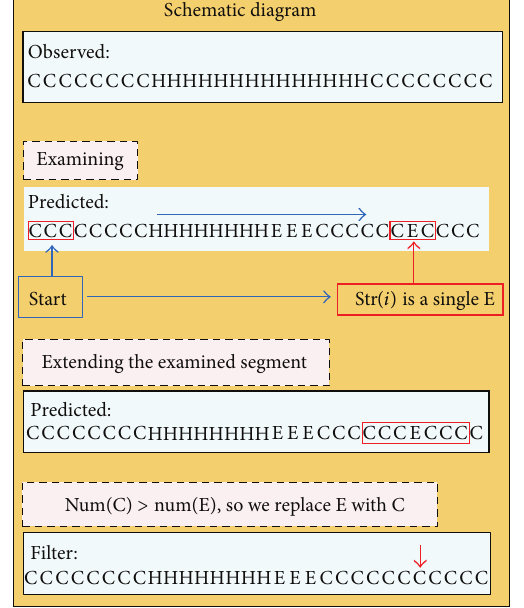
Table 4: Side chain mass of amino acids.